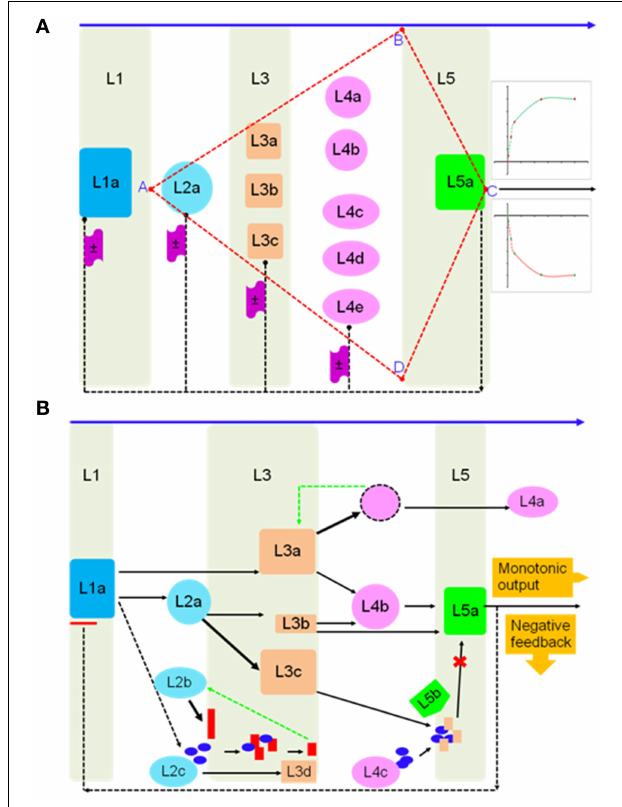
FIGURE 4 | System scalable architecture of a biochemical network in plant cells. (A) Hypothetical multi-layer model of initiation, consolidation, and termination phases of a stimulus-motivated response. The arrangement is tuned to exhibit an amplification or fast-dampening of the resultant output, and (B) molecular models of network behavior, viz. , feedback, competition, and bias, are implemented in a representation of weighted bi-directional information flow triggered by a declining essential